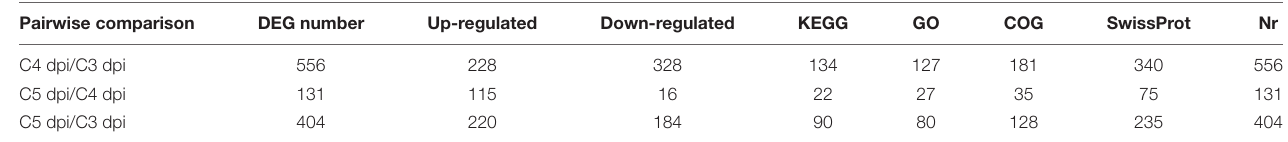
TABLE 2 | Differentially expressed genes (DEGs) and annotated gene number during conidiation of Bgt on Chancellor. Pairwise